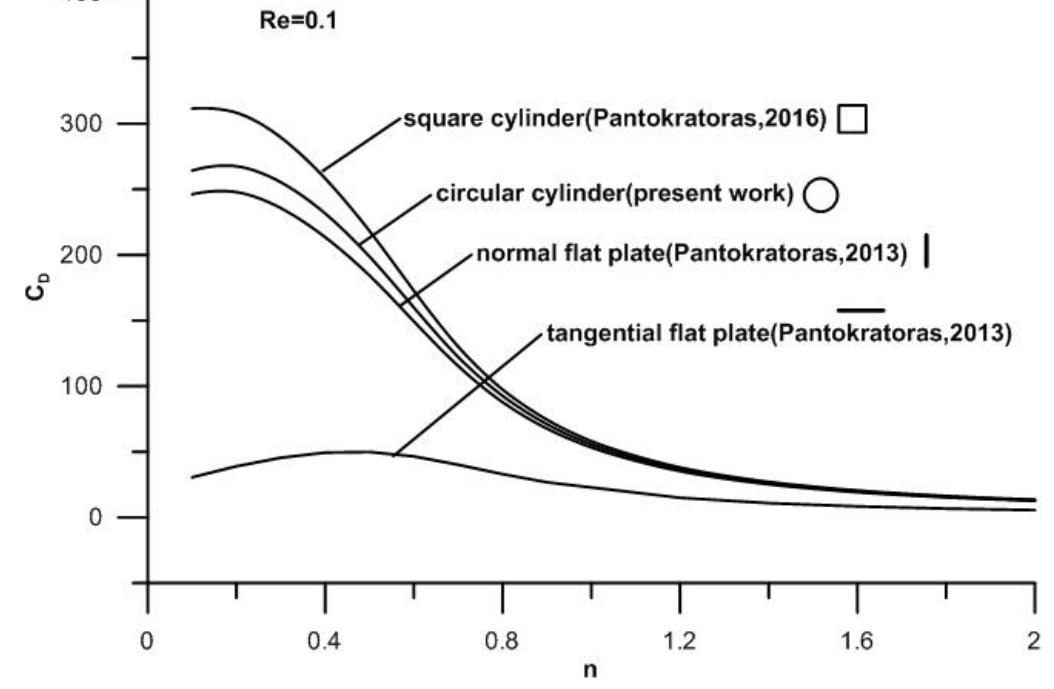
Figure 4. Variation of drag coefficient as a function of the power-law index for Re = 0.1.